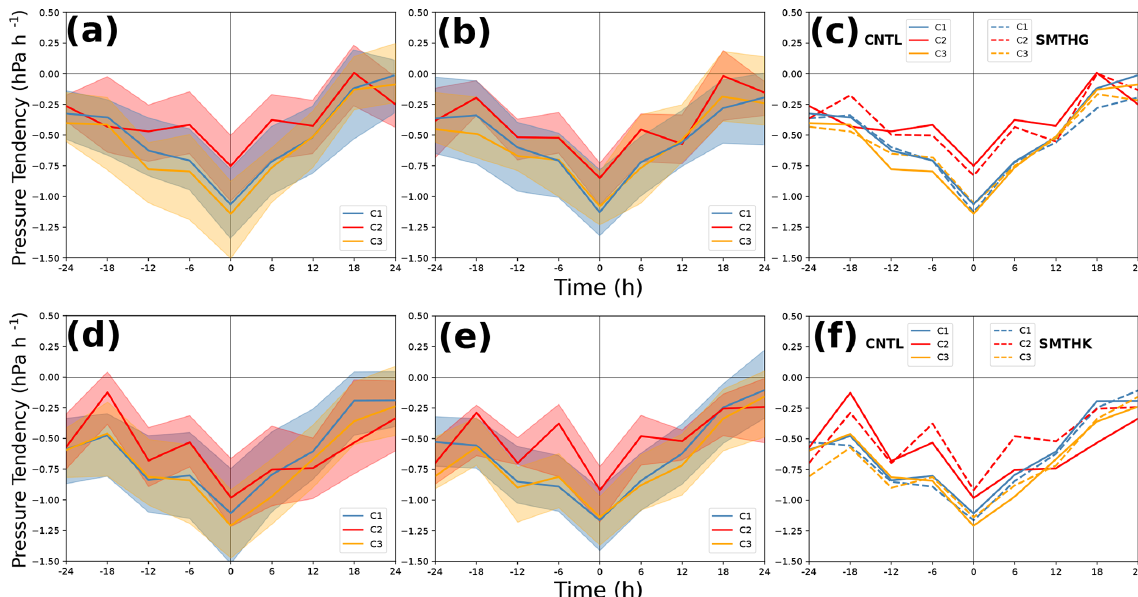
Figure 5. Pressure tendency (hPah − 1 ) for the three categories relative to the time of maximum intensification for (a) CNTL and (b) SMTHG. Lines indicate the median and the shading the interquartile range. (c) Medians of the pressure tendency (hPah − 1 ) for the three categories relative to the time of maximum intensification for CNTL (solid lines) and SMTHG (dashed lines). (d–f) As panels (a) – (c) but for the North